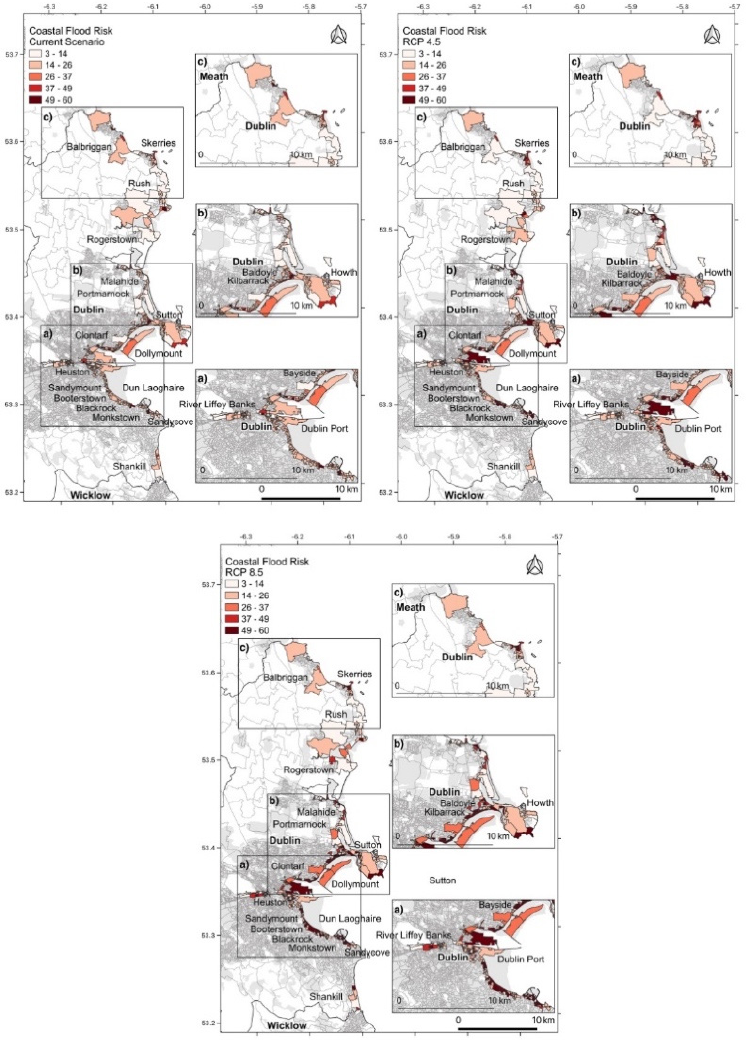
Figure 7. Coastal Flood Risk (R) index across County Dublin. The index ranges from 1 (very low risk) to 5 (very high risk). Panel information is as shown in Figure 3. Table 5. Number of SAs included in each class 1 to 5 (1 = very low, 2 = low, 3 = average, 4 = high, 5 = very high) of Hazard (H), Vulnerability (V), Exposure (E) and Risk indexes (R) classes